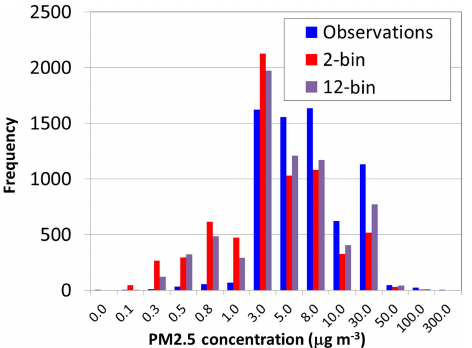
Figure 3. Histogram of surface PM 2 . 5 using Wood Buffalo Envi- ronmental Association surface monitoring data (blue) and the 2-bin (red) and 12-bin (purple) configurations of GEM-MACH. Both sim- ulations make use of the original Briggs (1984) plume-rise formu-